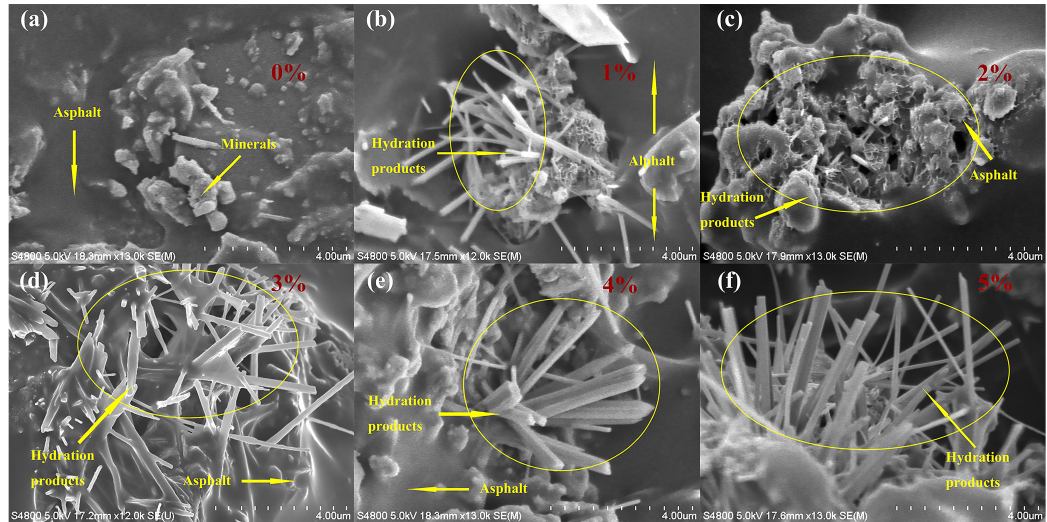
Figure 5. Microstructure of mortar with di ff erent contents of cement. ( a ) Without cement. ( b ) With 1% cement. ( c ) With 2% cement. ( d ) With 3% cement. ( e ) With 4% cement. ( f ) With 5%